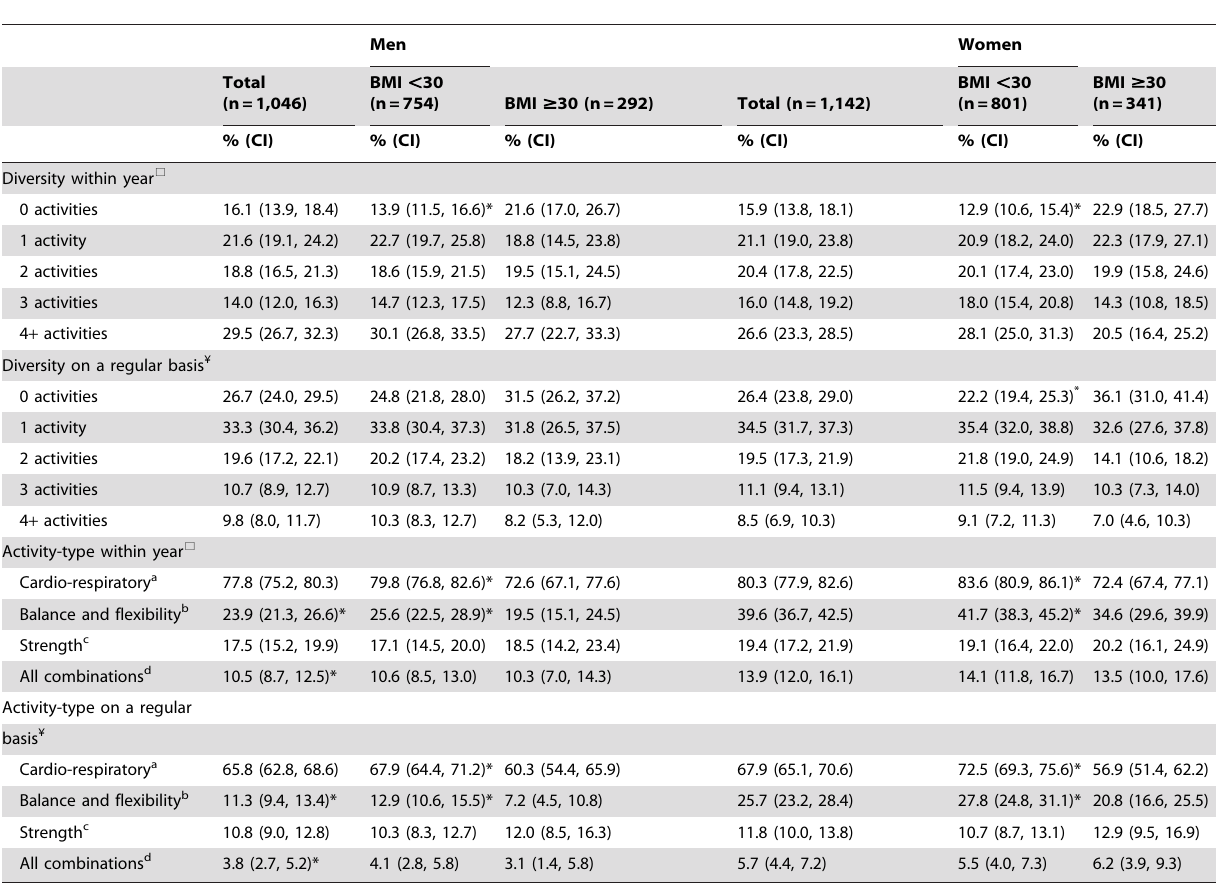
Table 2. Diversity in leisure-time physical activity and participation in different activity-types, % (CI), by gender and obesity